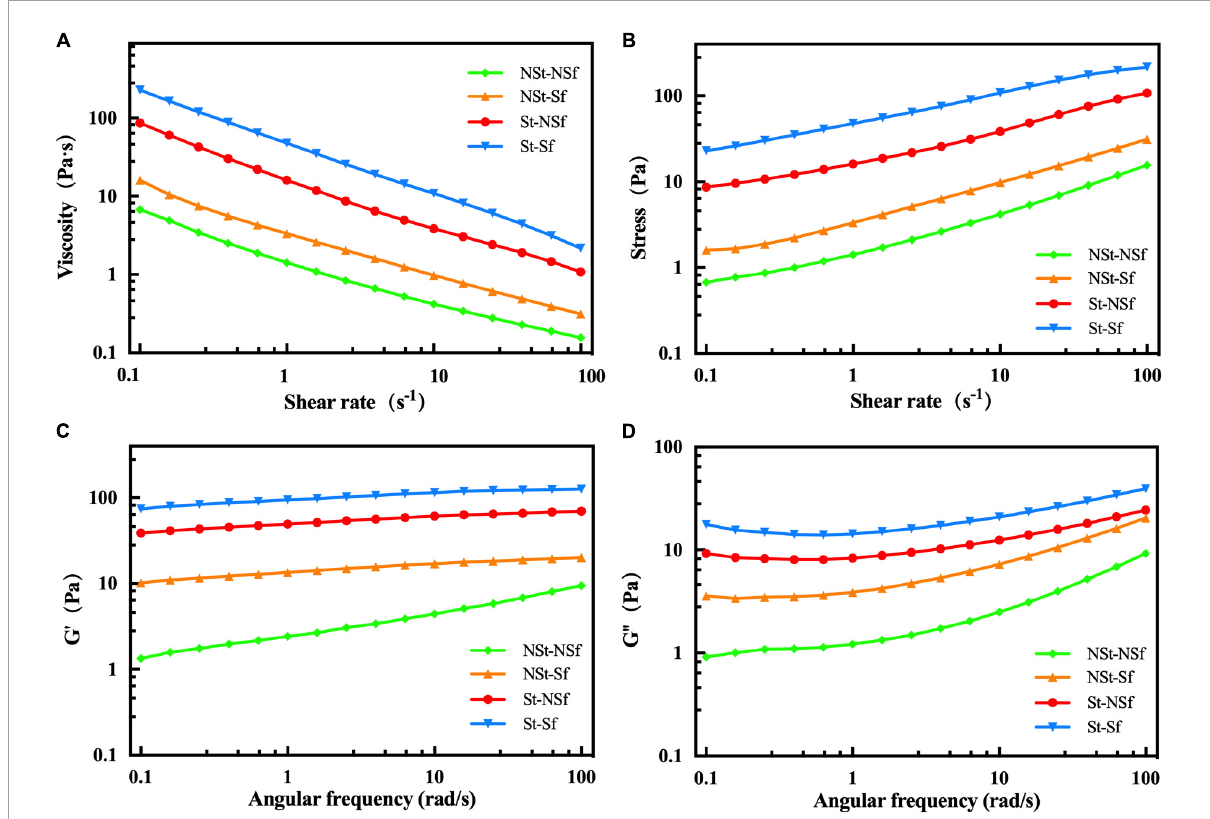
FIGURE8 Stable shear flow curves of viscosity changes with shear rate (A) and stress changes with shear rate (B) . The changes in storage modulus (G (cid:48) ) (C) and loss modulus (G (cid:48)(cid:48) ) (D) of Gastrodia elata starch at 25 ◦ C and 1%